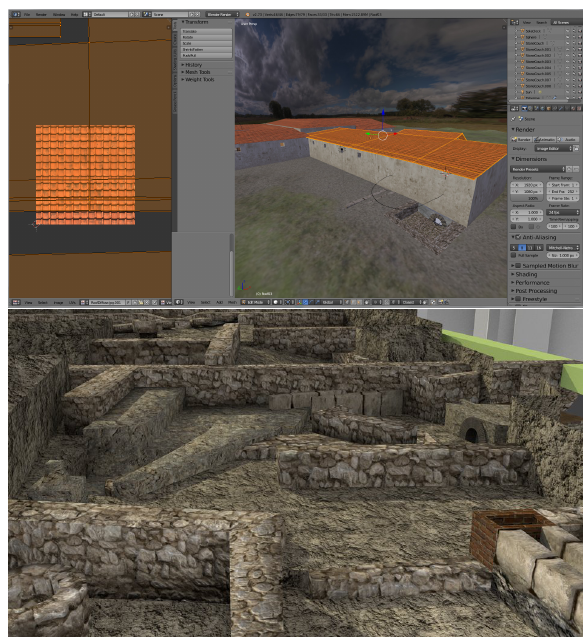
Figure 4: UV mapping of the roof in Blender (top) and render of the reconstruction of the archaeological vestiges (bottom).